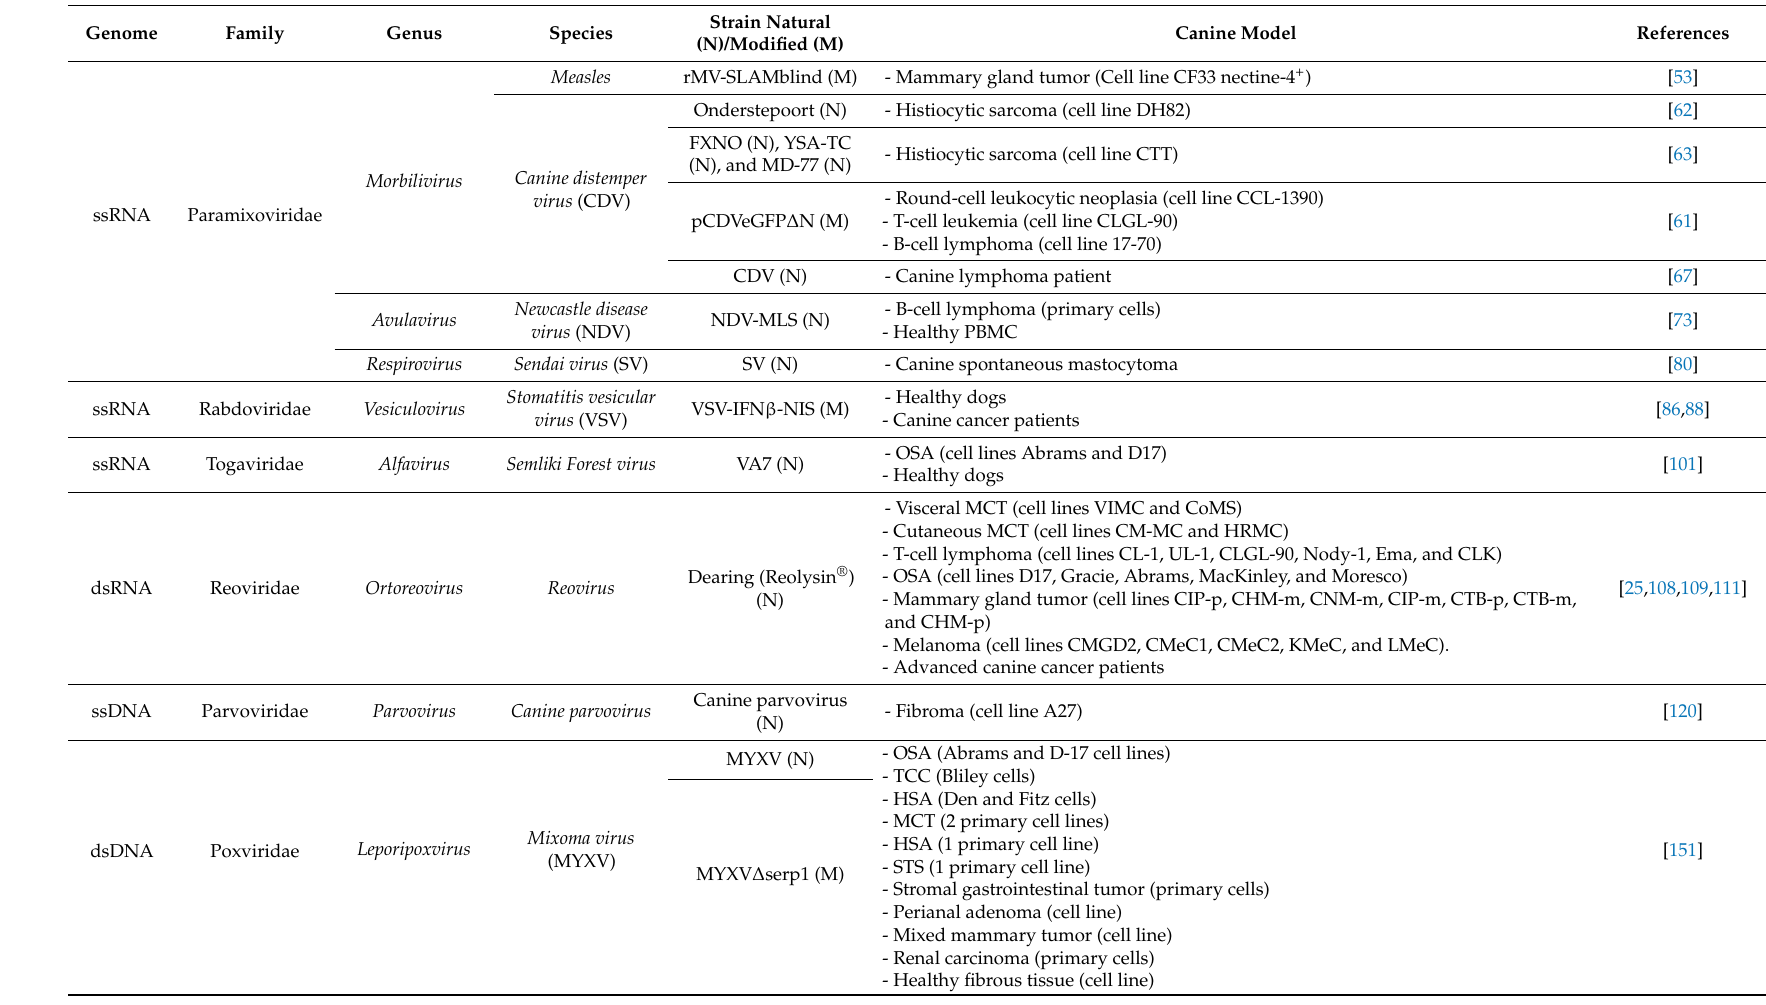
Table 3. Oncolytic viral strains studied in